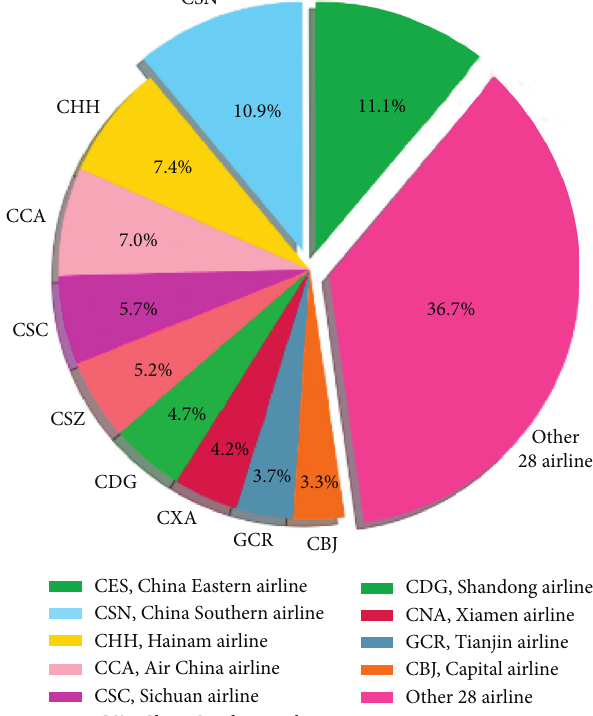
Figure 4: Proportion of airlines applying to revise standard